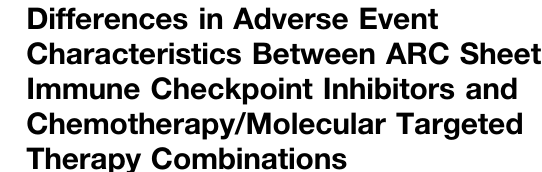
the ARC sheet use and non-use groups ( Table 2 ).